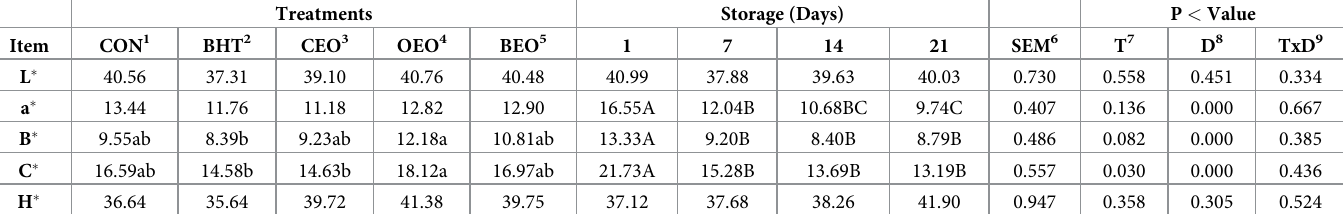
Table 3. Evolution of CIE color parameters (L � , a � , b � , C � and H � ) in beef patties treated with BHT, copaiba and oregano essential oil or blend of essential oils dur- ing storage. Treatments Storage (Days) P <